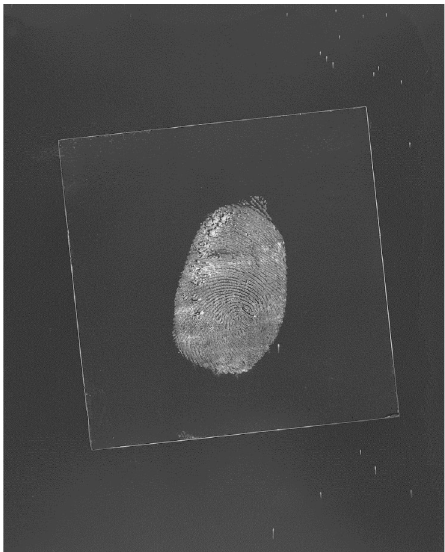
Fig. 1. Susanne Ramsenthaler. From the series Household Forensics . Photogram on Polaroid fi